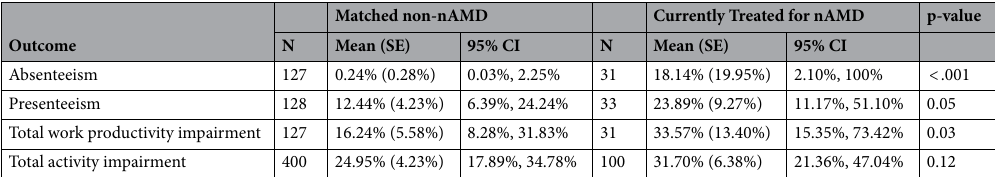
Table 5. Adjusted means with 95% CIs examining the effect of treated nAMD on work productivity and activity impairment after controlling for demographics and health characteristics among currently-treated nAMD patients and matched non-nAMD respondents. CI confidence interval, nAMD neovascular age-related macular degeneration, SE standard error.